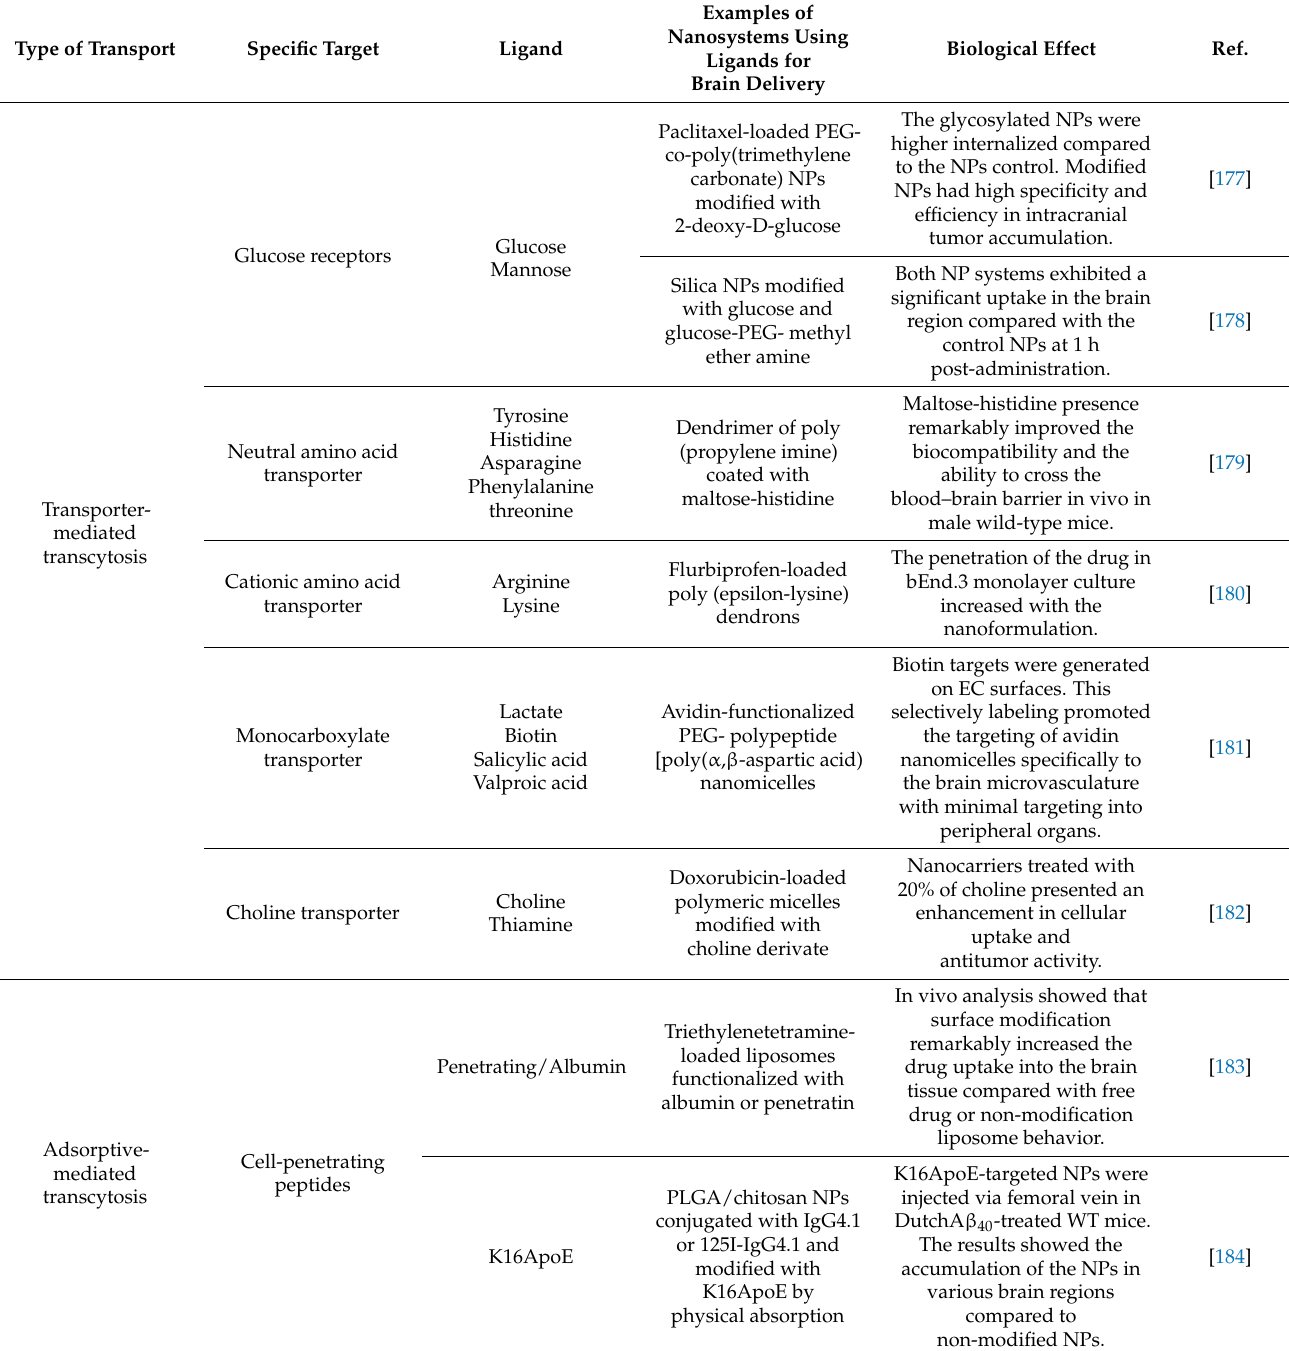
Table 4. Different ligands used in nanoparticle coatings for brain targeting and drug